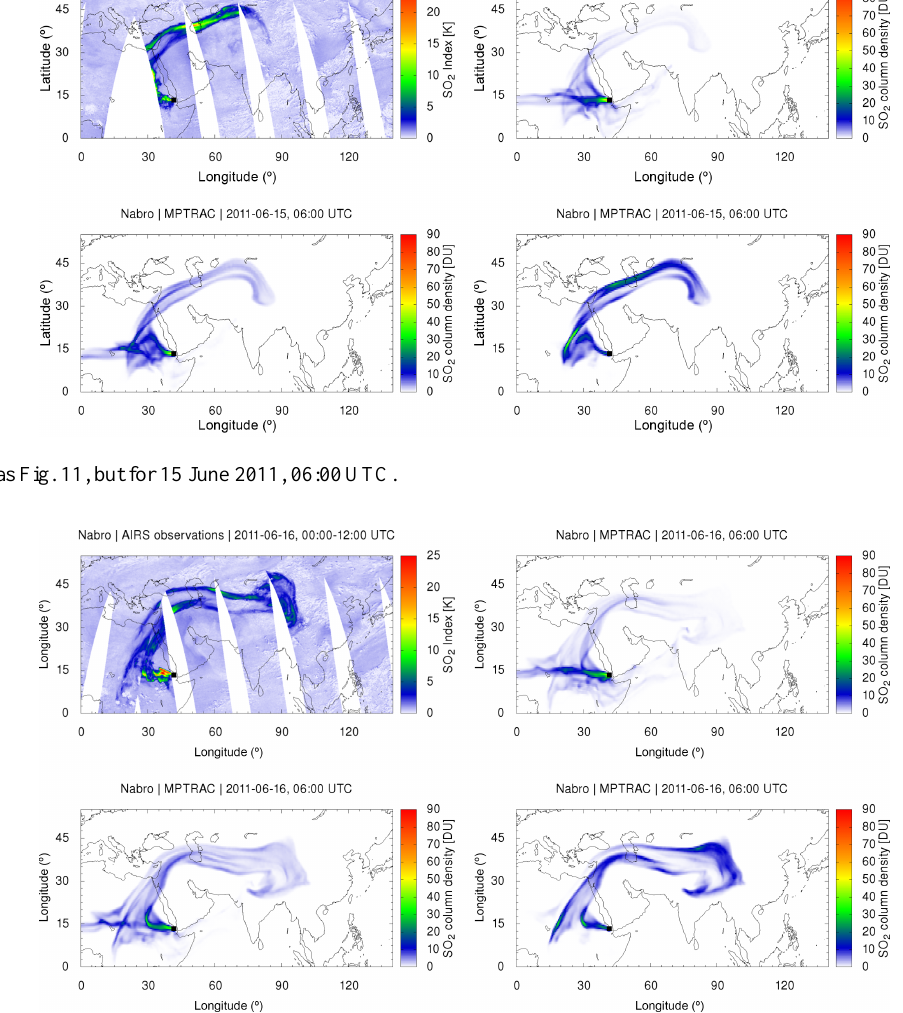
Figure 14. Same as Fig. 11, but for 16 June 2011,